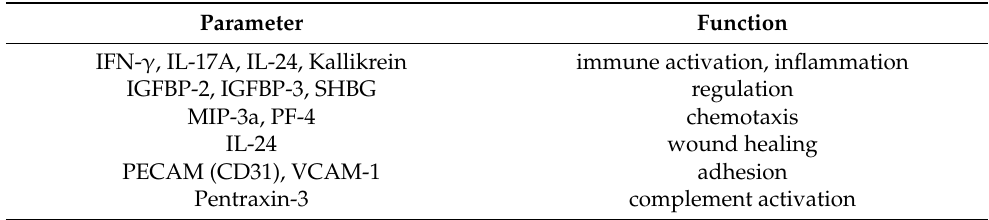
Figure 7. Parameters with explorative significant differences in non-parametric pair comparison without α correction (part 2). There is a risk of false positive significances. ‘*’ indicates p * < 0.05. Ctrl (control), PLGA (poly(lactic-co-glycolic acid), CS (calcium sulphate scaffold), PMMA (polymethylmethacrylate). (Ctrl: control; LPS: Lipopolysaccharide; PLGA: poly(lactic-co-glycolic acid; CS: calcium sulphate scaffold; PMMA: polymethylmethacrylate). Table 3. Expressed parameters with explorative significant differences between groups and assignment to functional categories.